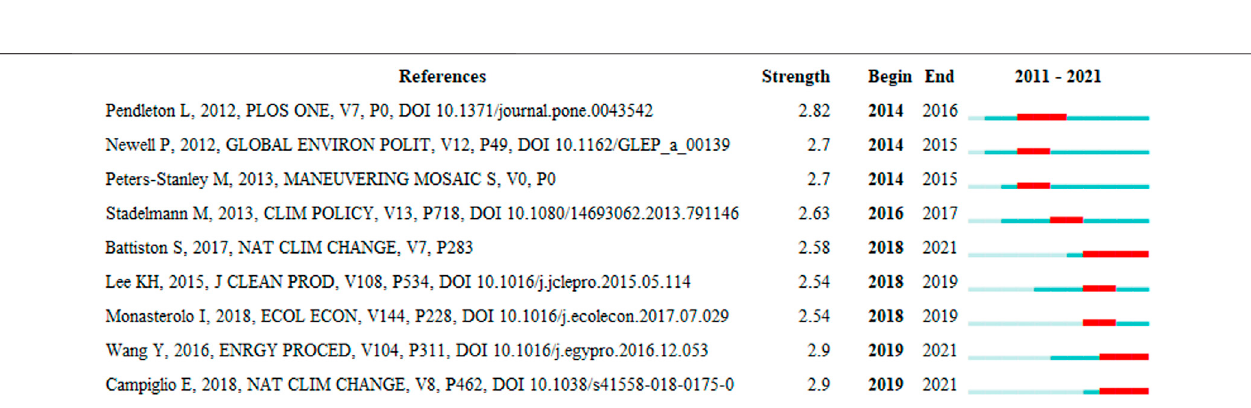
Frontiers in Environmental Science |